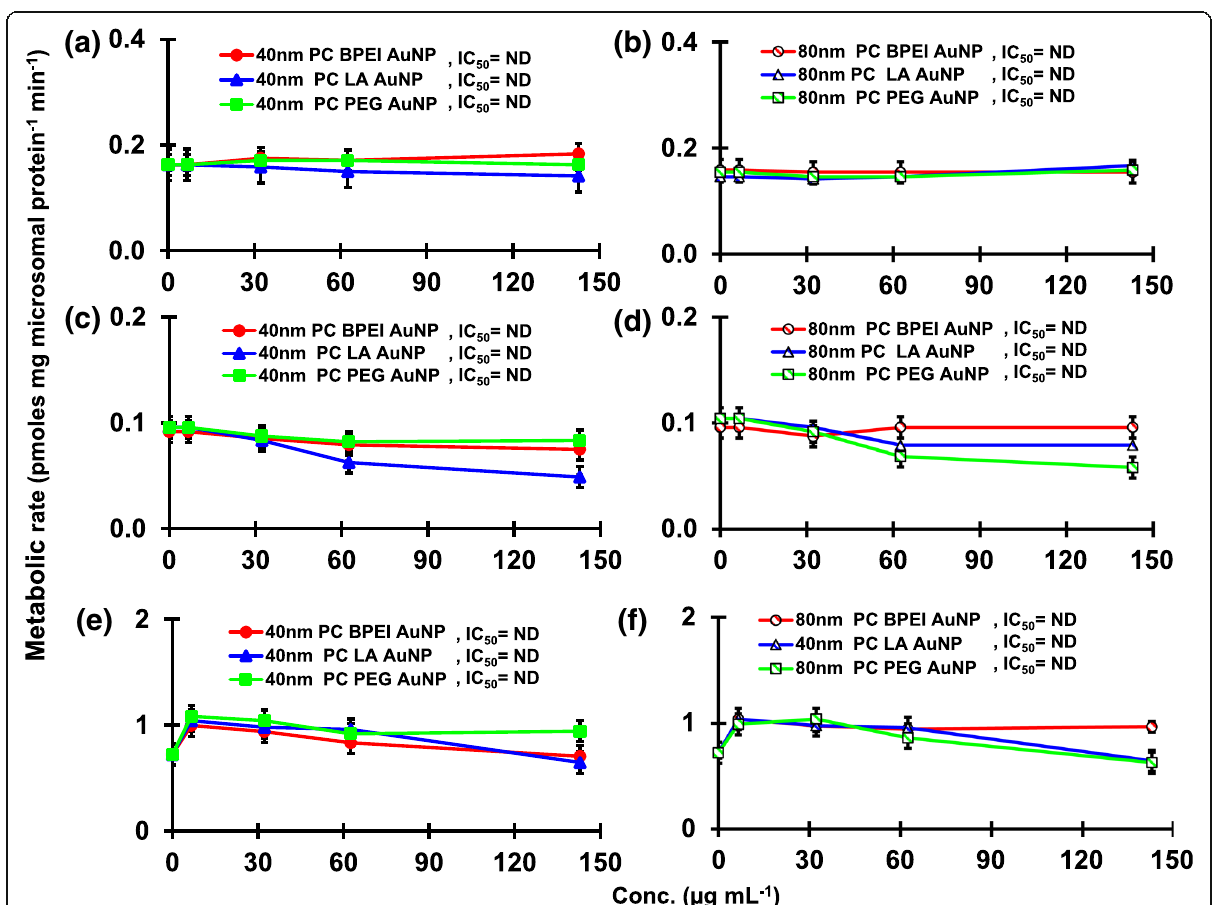
Fig. 6 Effects of PC AuNP on the production of 16 α -OH TST ( a , b ), 16 β -OH TST ( c , d ) and AD ( e , f ) in pHLM. Data represent mean ± S.D. ( n =3). pHLM , pooled human liver microsomes; ND , not determined by fitting a Hill equation with variable slope to IC 50 , half maximal inhibitory conc.; the observed data using GraphPad Prism®; PC , human plasma protein corona; BPEI , branched polyethylenimine; LA , lipoic acid; PEG , polyethylene glycol; Conc, concentration; 16 α -OH TST, 16 α -hydroxytestosterone; 16 β -OH TST, 16 β -hydroxytestosterone; AD ,